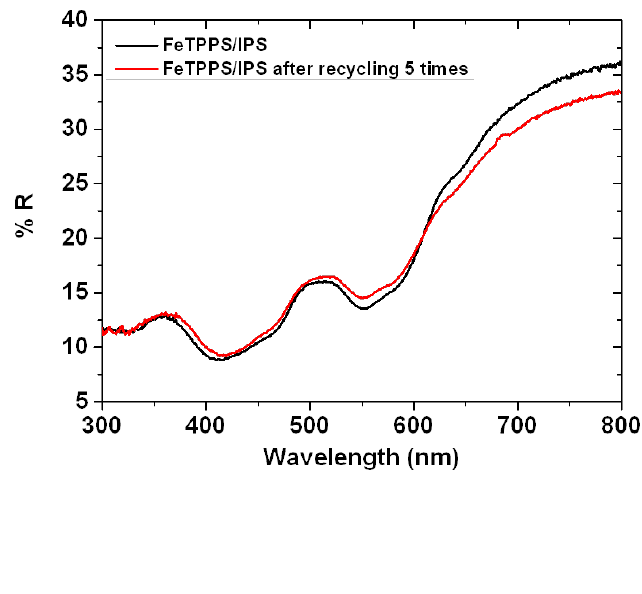
Figure 8. Diffuse reflectance UV-vis spectra for the FeTPPS/IPS catalyst before and after five